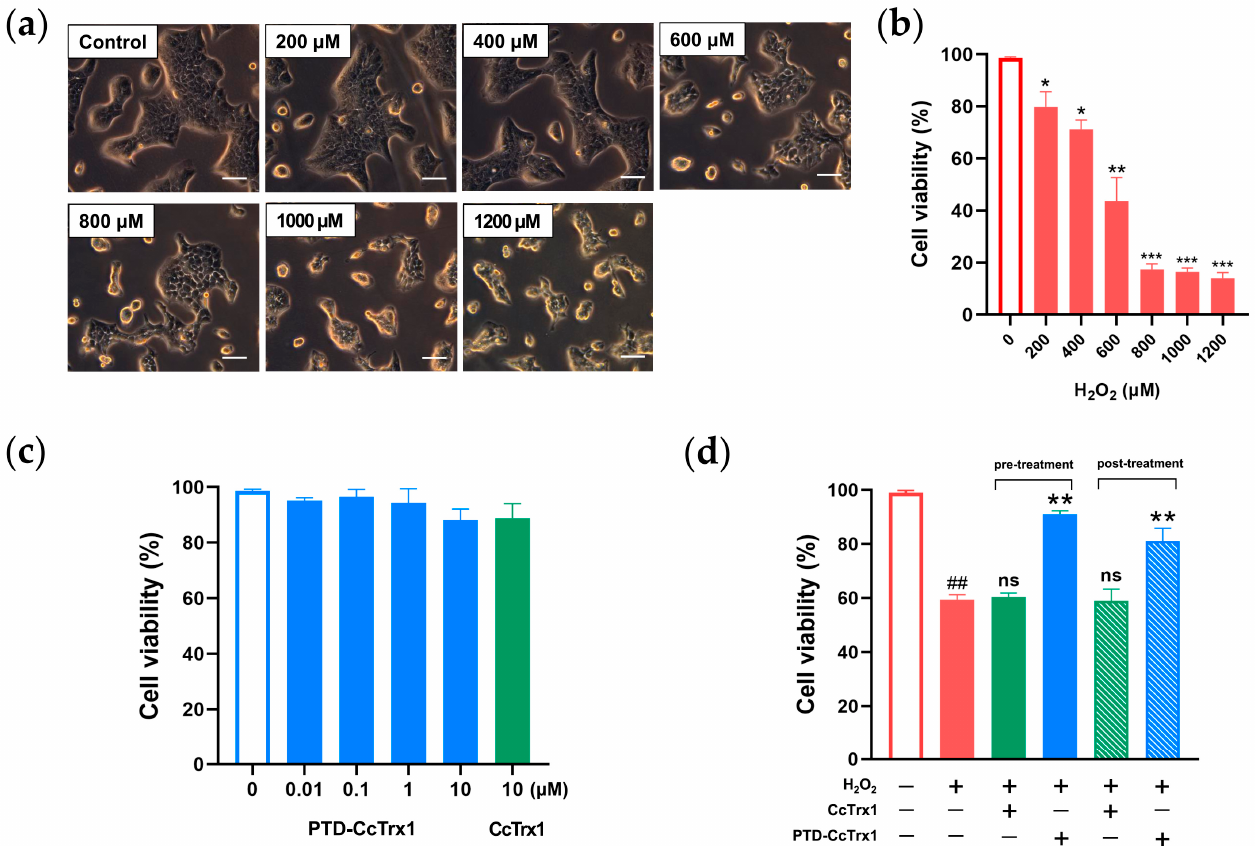
Figure 4. Protective effects of PTD-CcTrx1 against H 2 O 2 -induced cytotoxicity in HaCaT cells. ( a ) Representative morphological changes of HaCaT cells, which were treated with different concen- trations of H 2 O 2 and observed with a phase contrast microscope. Bar = 100 μ m. ( b ) HaCaT cells were treated with increasing concentrations of H 2 O 2 (0, 200, 400, 600, 800, 1000, 1200 μ M) for 4 h (* p < 0.05, ** p < 0.01, *** p < 0.001 vs. control group). ( c ) HaCaT cells were treated with increasing concentrations of PTD-CcTrx1 (0, 0.01, 0.1, 1, 10 µ M) and 10 µ M CcTrx1 for 12 h. ( d ) HaCaT cells were treated with 10 µ M PTD-CcTrx1 and 10 µ M CcTrx1 before or after the exposure to 400 µ M H 2 O 2 . All treat- ments were performed in triplicate individually, and the data are presented as means ± SD ( n = 3) (## p < 0.01 vs. control group; ns, no significance, ** p < 0.01 vs. H 2 O 2 alone